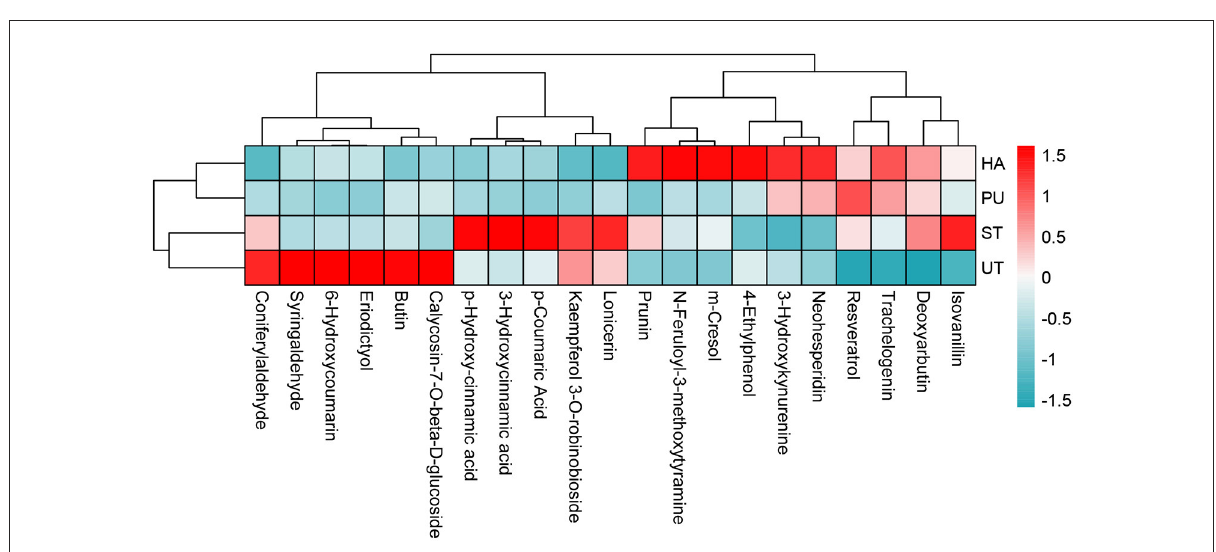
FIGURE10 Heatmap of CP with VIP > 1 in camellia oil.